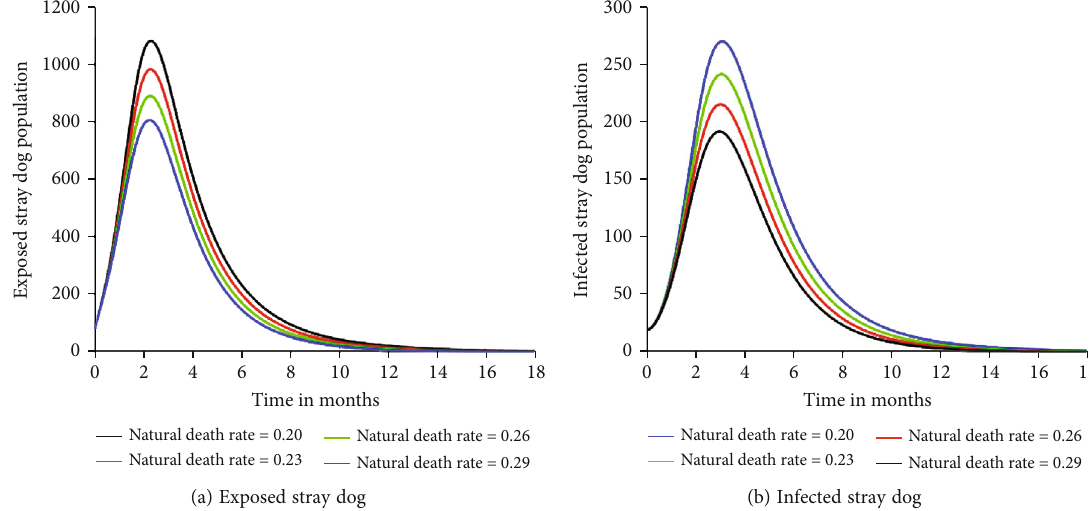
Figure 4: The impact of natural mortality rate (parameter μ ) on the exposed and infected stray dog populations.